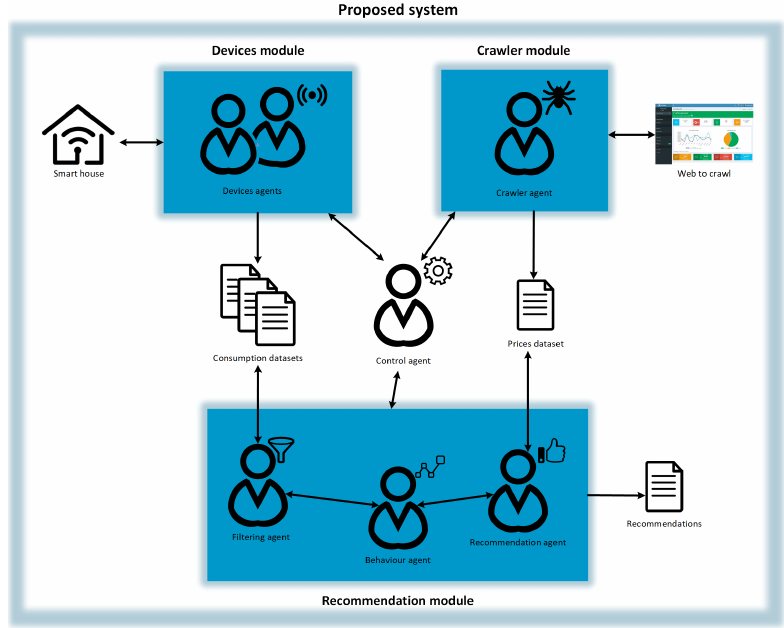
Figure 1. Architecture of the proposed multiagent